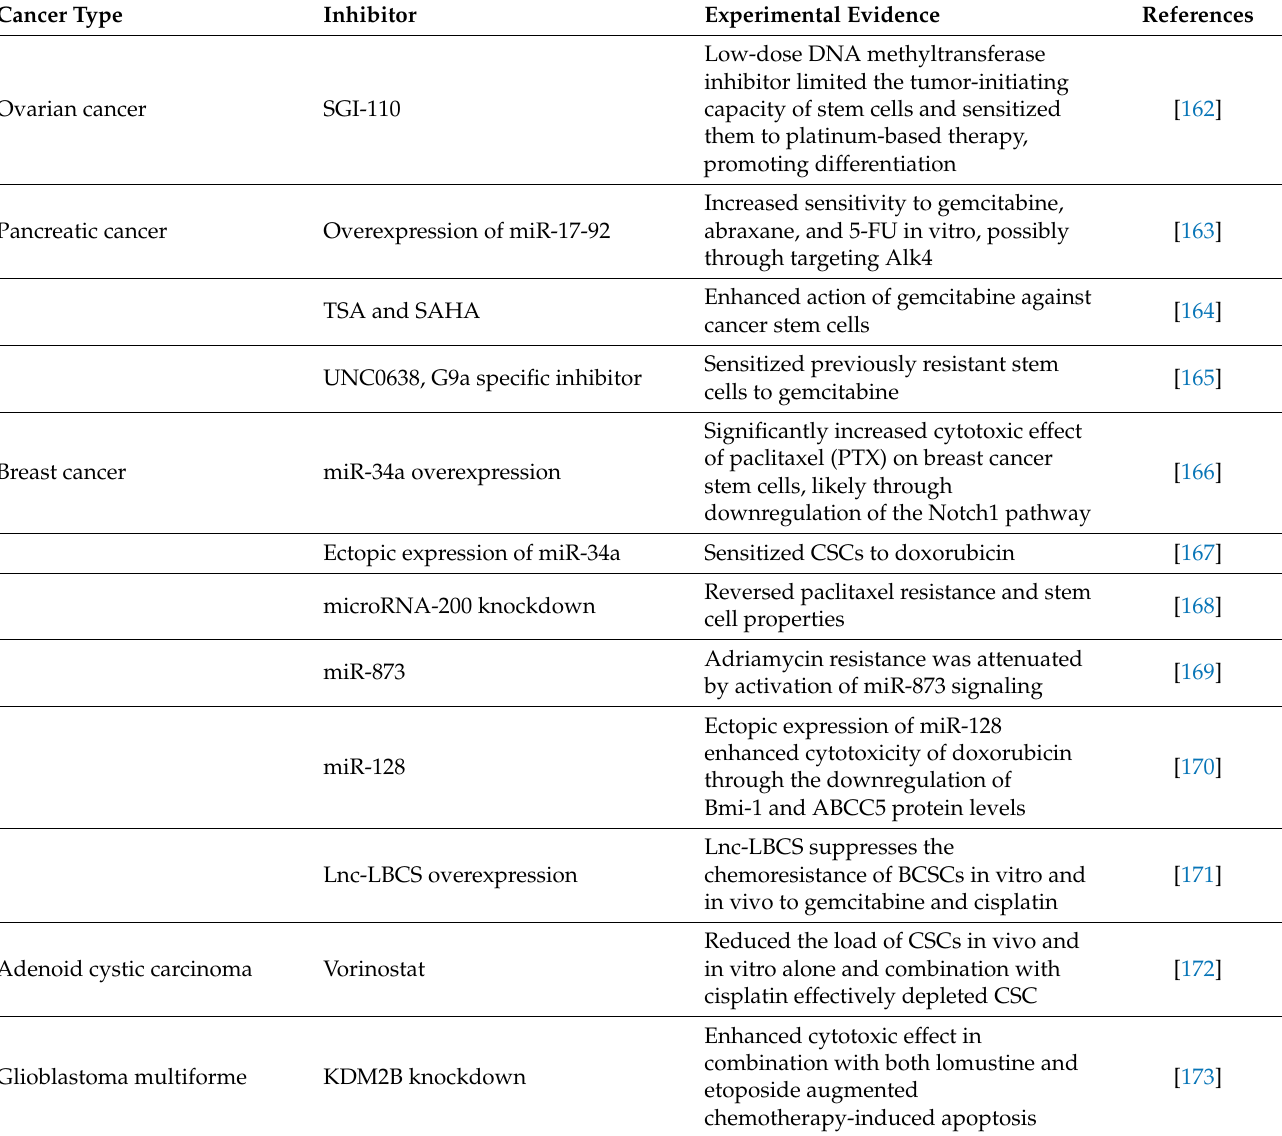
Table 6. Summary of evidence for the role of epigenetics microenvironment in chemoresistance of cancer stem